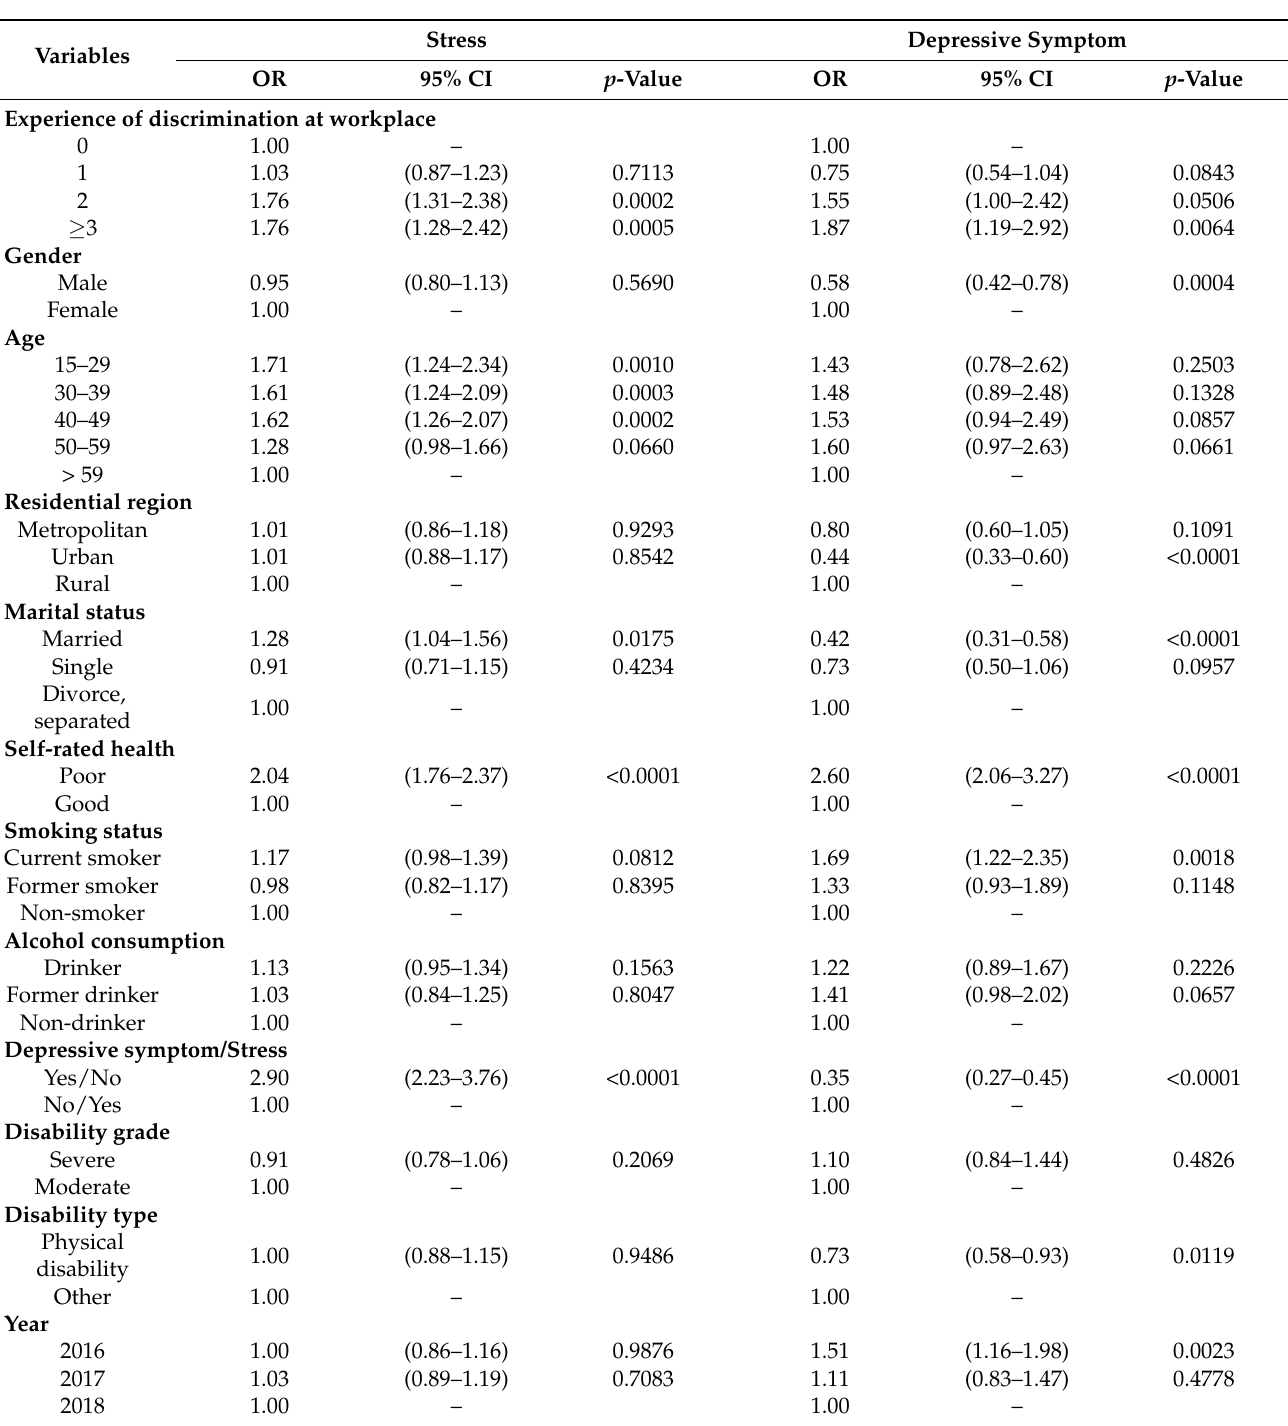
Table 3. Association between experiences of discrimination at the workplace and stress/ depres- sive